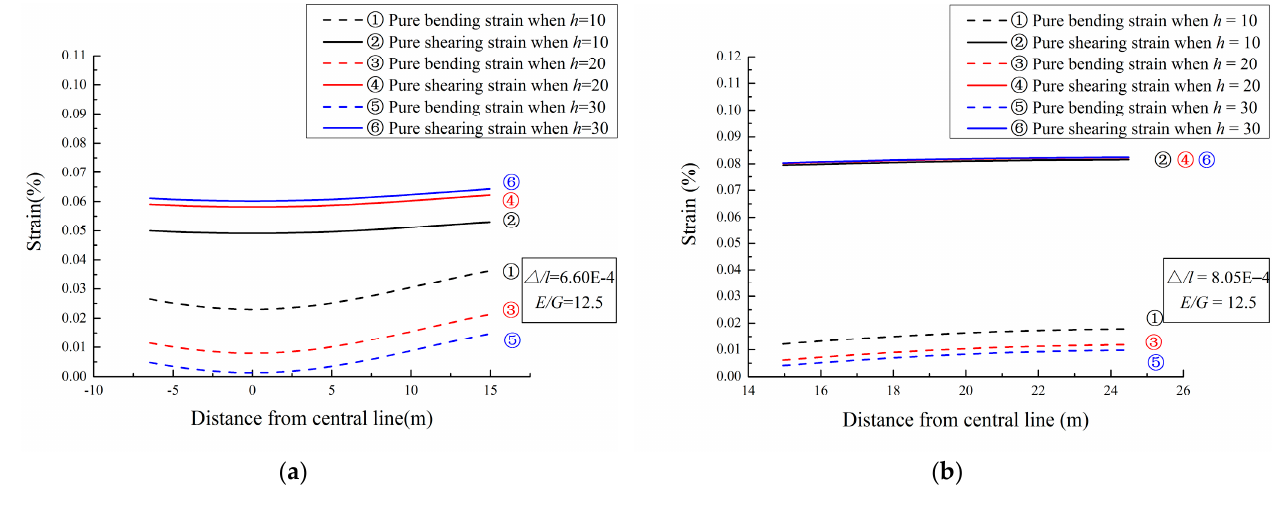
Figure 17. Effect of the height of the building on the tensile strain in ( a ) the sagging zones and ( b ) the hogging zones .